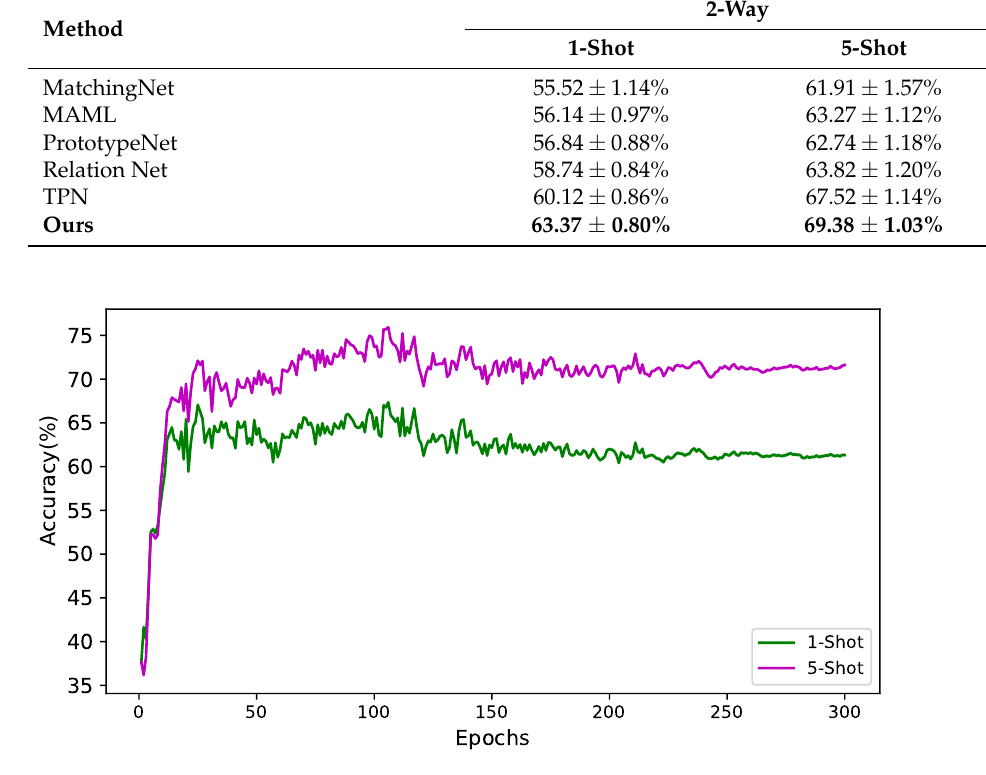
Figure 5. Validation accuracy curve on the DermaMNIST dataset.